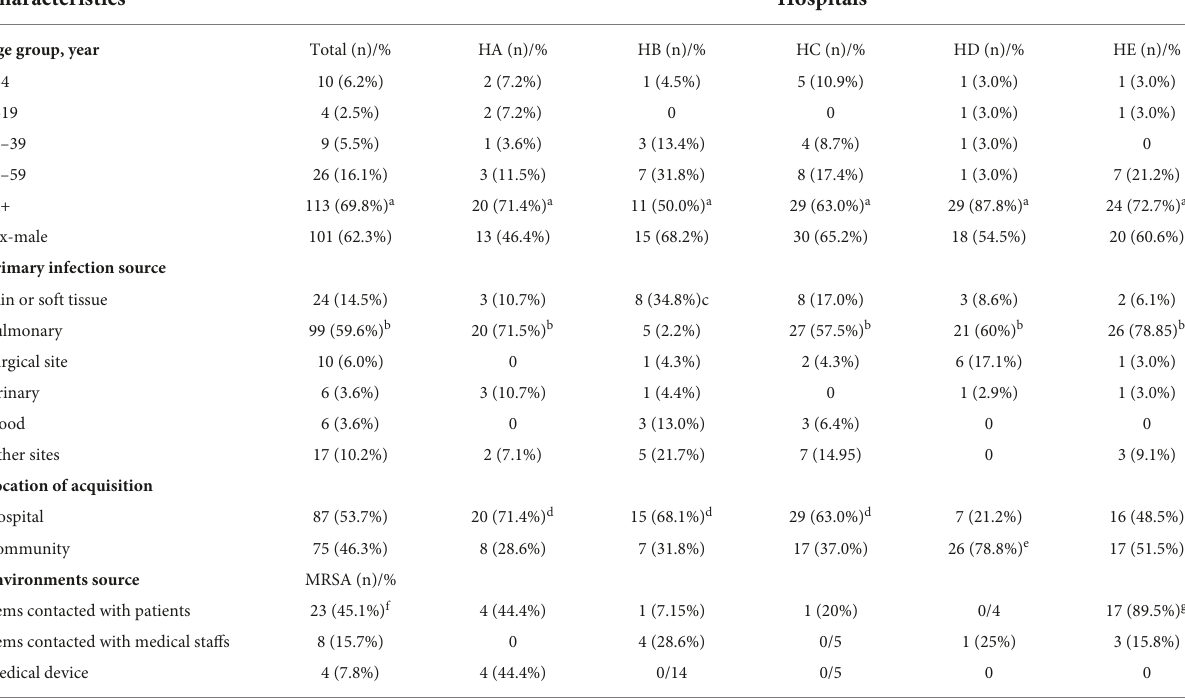
TABLE 1 Clinical characteristics of methicillin-resistant Staphylococcus aureus (MRSA) infections during 2017–2019 in Shanghai, China.